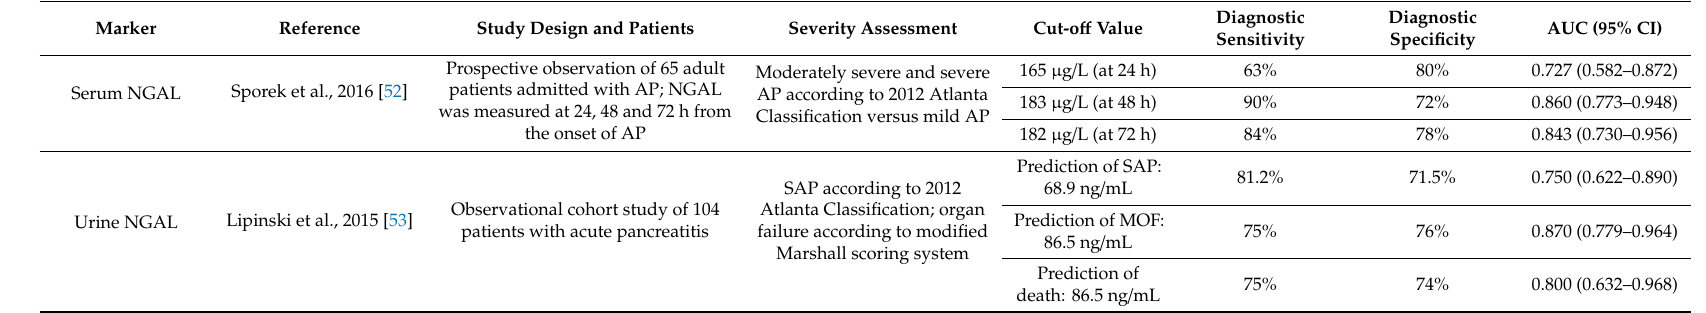
Table 4. Novel laboratory markers of renal dysfunction or injury associated with prognosis or diagnosis of AP